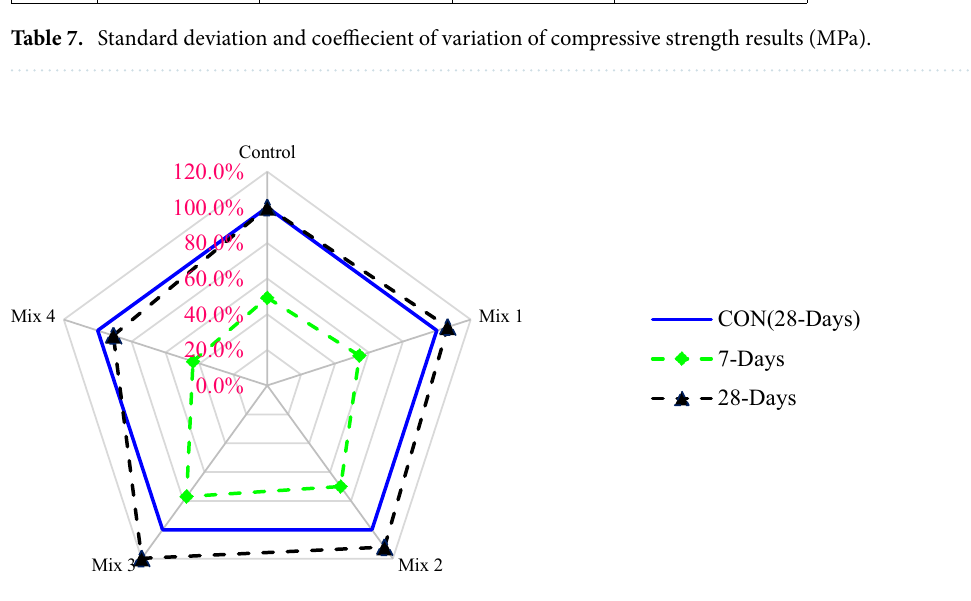
Figure 4. Relative analysis of compressive